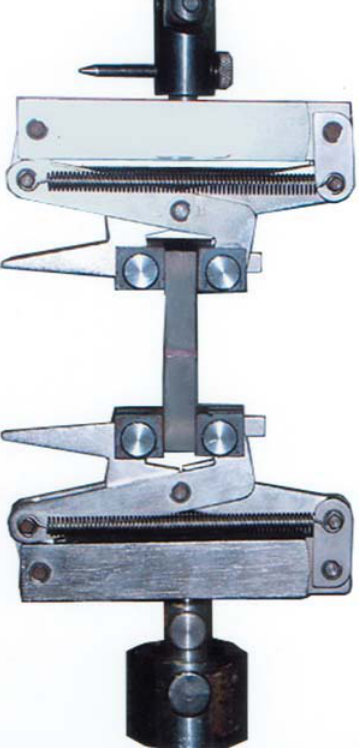
FIGURE 4- Shear strength specimen in the universal testing